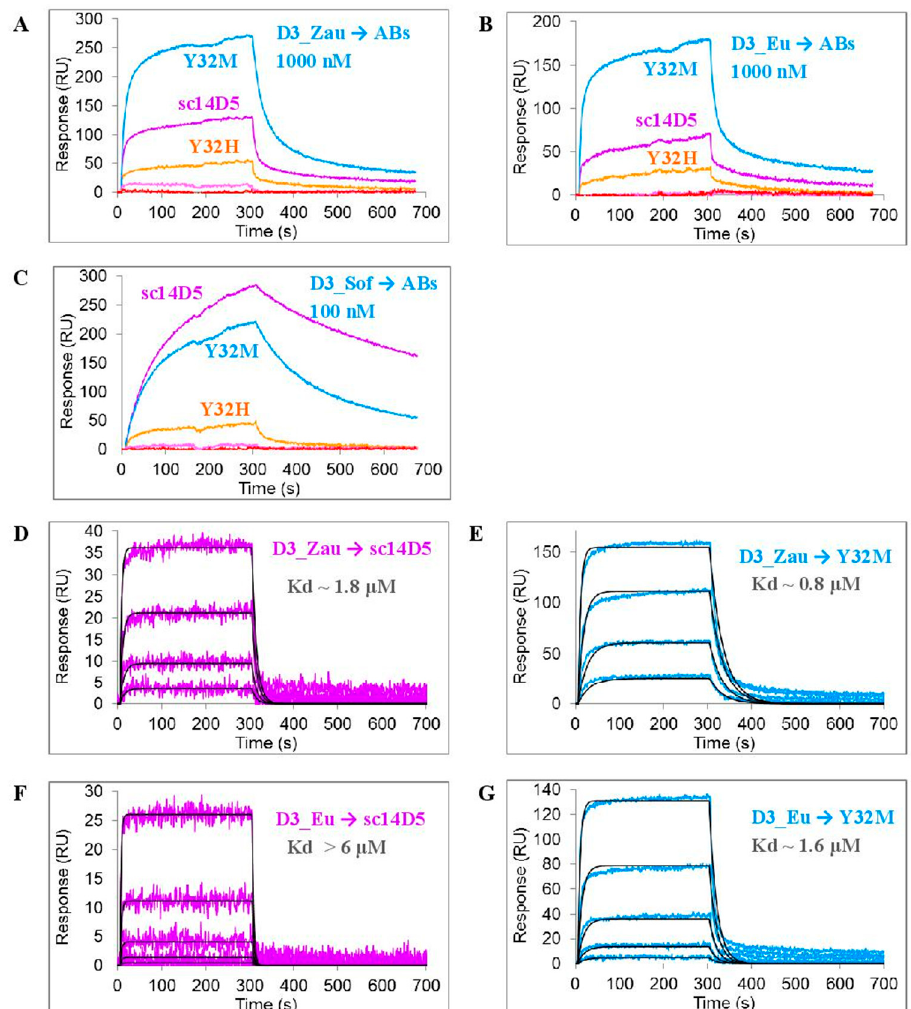
Figure 2. Binding of recombinant D3 proteins to mutant variants of the sc14D5 antibody: ( A–C ) Screening of antibody variants. D3_Zau, D3_Eu, and D3_Sof proteins were used in 1000 nM, 1000 nM, and 100 nM concentrations, respectively. The differences in the concentrations used are due to the differences in the affinity of the studied antibodies with respect to D3 proteins. ( D–G ) Measurement of affinity constants. D3 proteins were used as threefold dilutions starting from 3.24 µ M concentration. Experimental curves are shown by colored lines, approximations are shown in black. The analysis was carried out using a ProteOn XPR36